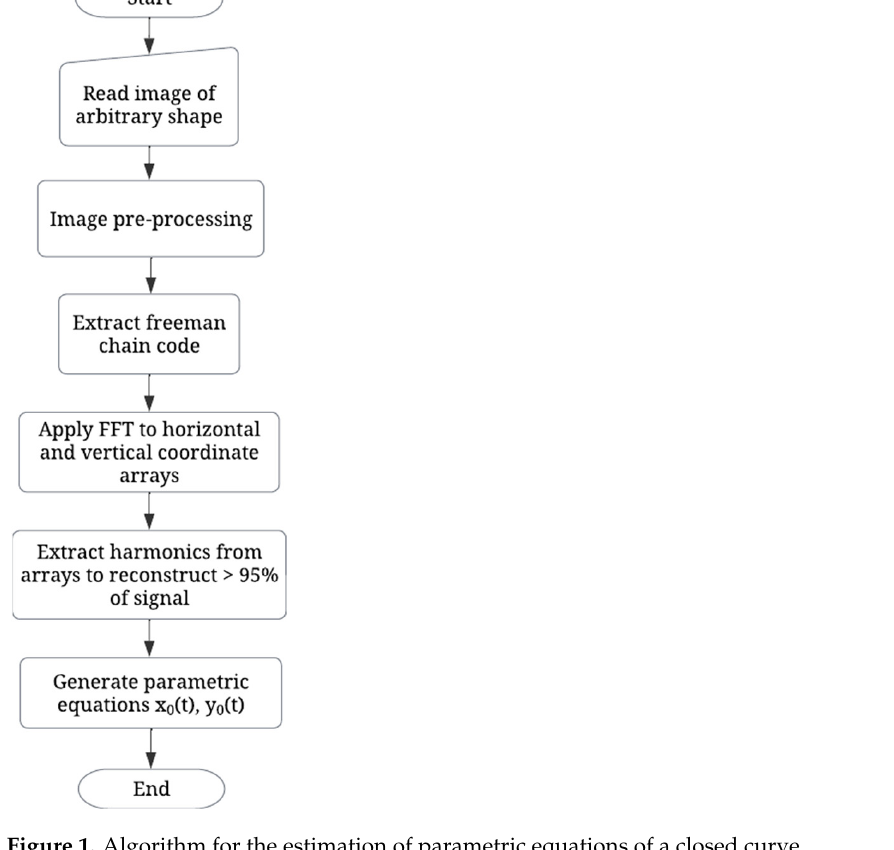
Figure 1. Algorithm for the estimation of parametric equations of a closed curve.